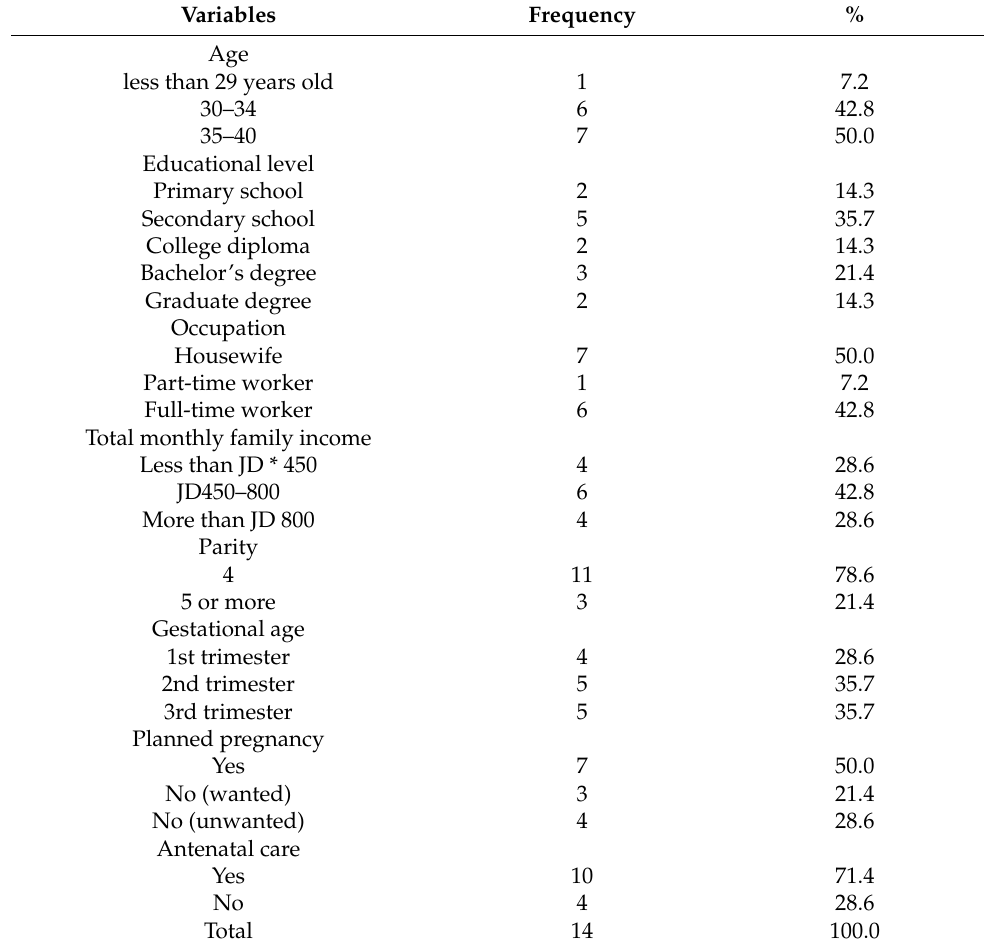
Table 1. Characteristics of participants ( n =